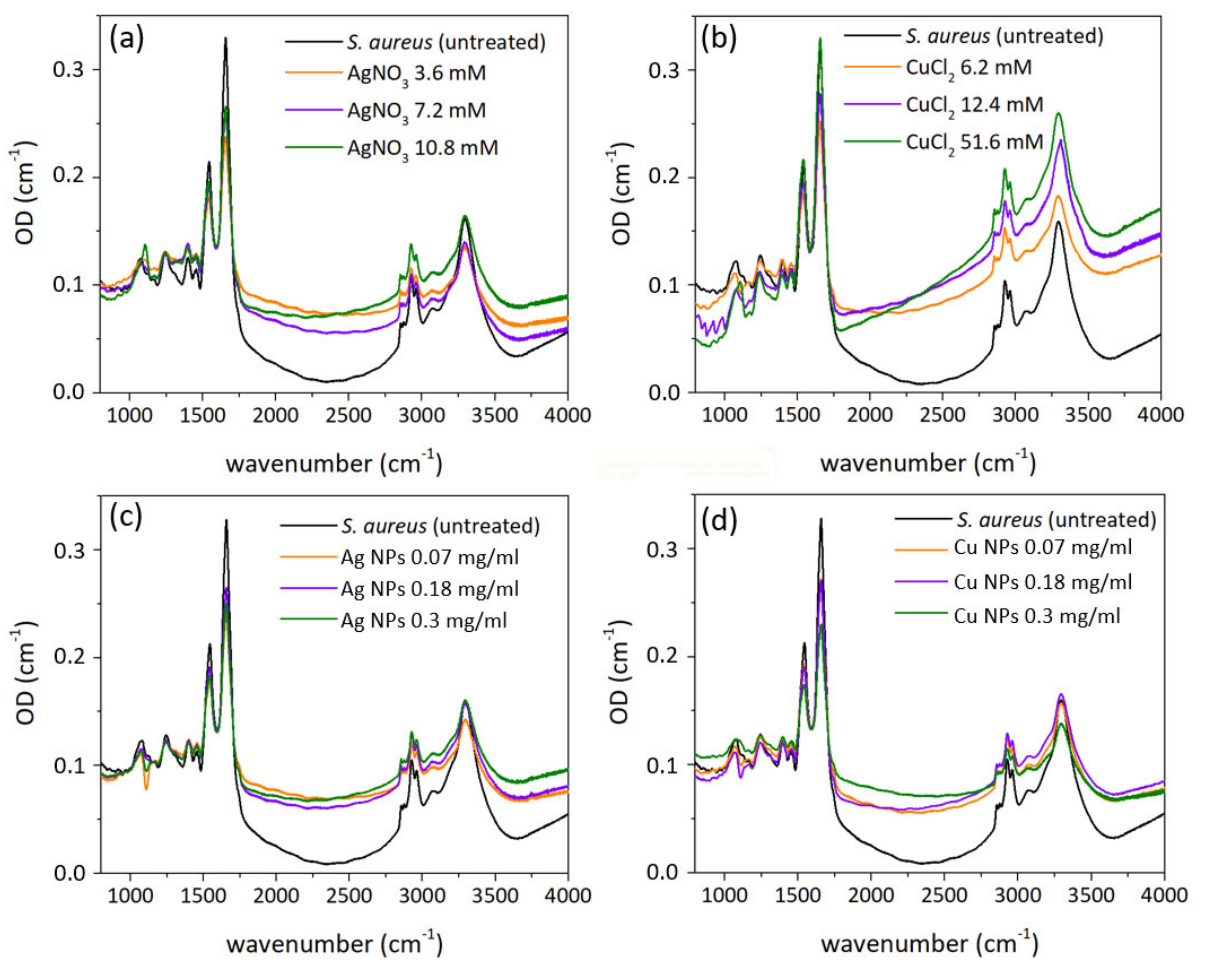
Figure 7. FT − IR optical density (OD) spectra of S. aureus before and after treatment with ( a ) AgNO 3 , ( b ) CuCl 2 , ( c ) Ag NPs, and ( d ) Cu NPs solutions with different concentrations. Table 1. IR band assignments of bacteria (treated with antibacterial agents and Gram ‐ positive bacteria have a thick layer of peptidoglycan (PG, 40–80% of the cell wall) [59]. Their primary structure consists of parallel polysaccharide chains of alternating N ‐ acetylglucosamine (NAG) and N ‐ acetylmuramic acid (NAM) residues joined by β (1 → 4) glycosidic bonds with parallel chains being linked by penta ‐ or tetrapeptides. Gram ‐